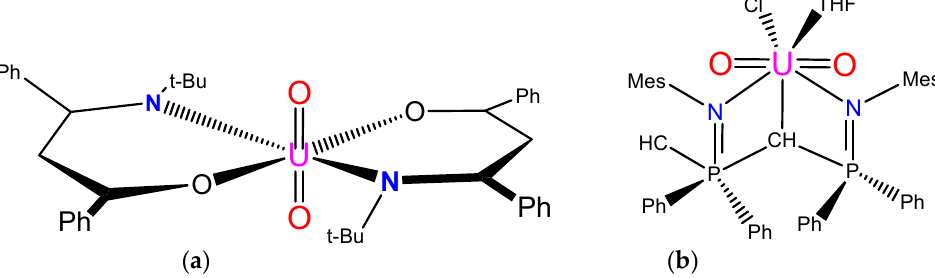
Figure 34. Structures of Uranyl(VI) monomers ( a ) β -Ketoiminate and ( b ) Carbenes Complexes [79].